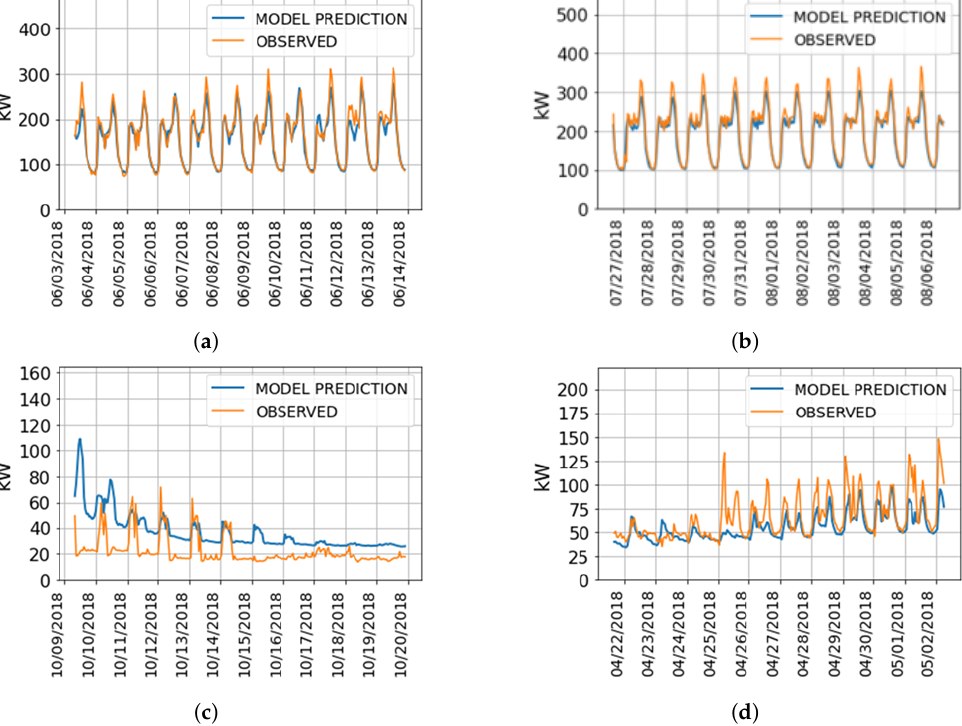
Figure 10. 24 h ahead load forecasting in transition and high season. ( a ) Middle of high season. ( b ) Middle of high season. ( c ) Transition from high season. ( d ) Transition to high